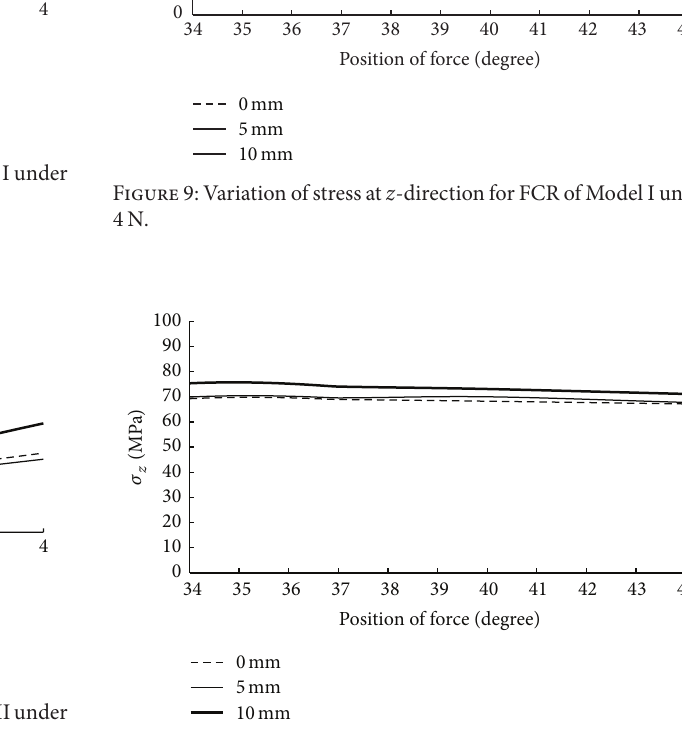
Figure 10: Variation of stress at z -direction for FCR of Model II under 4 N.